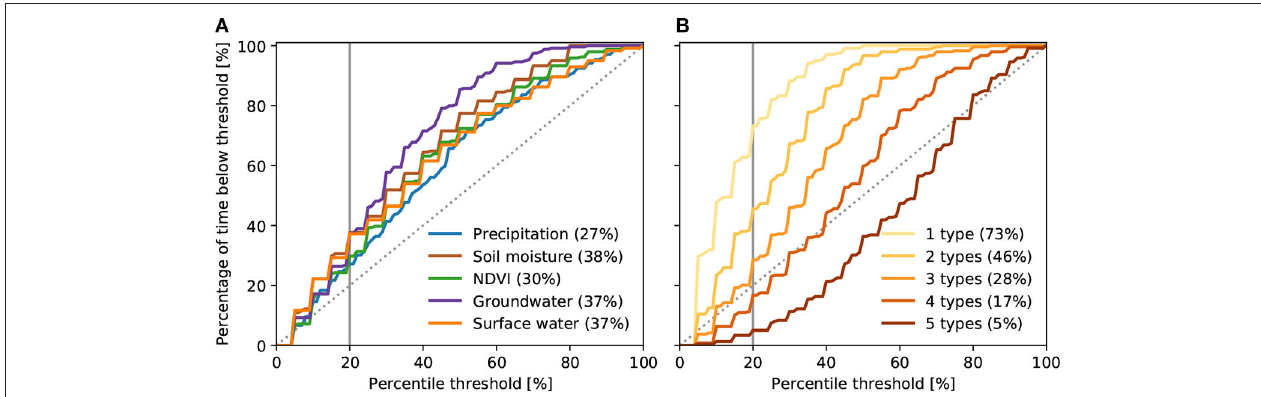
FIGURE 8 | Relation between drought threshold and percentage of time in a drought. (A) Shows the percentage of time each variable is below the corresponding threshold. (B) Shows how often the area is in drought conditions for a different number of variables considered. The dotted line in both panels shows the 1:1 line. Value between brackets shows the percentage of time each variable in drought conditions at the 20% percentile